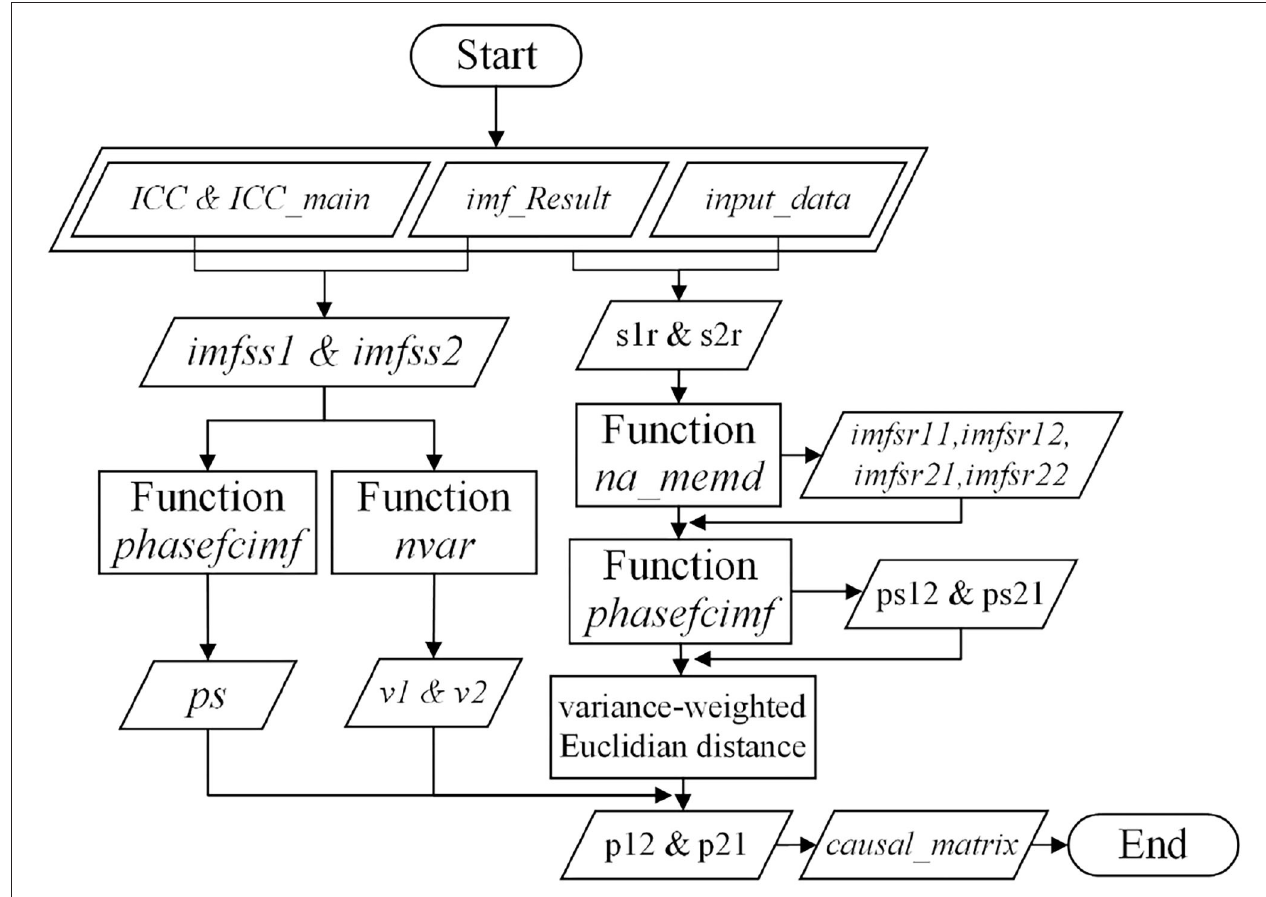
FIGURE 4 | The workflow of function causal _ decomposition